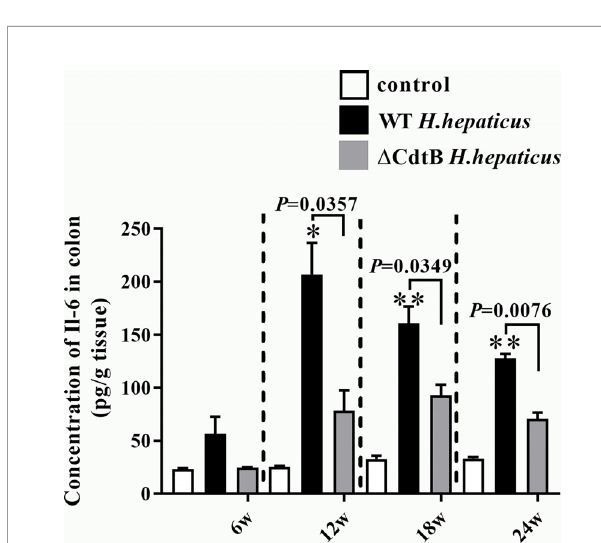
FIGURE 4 | H. hepaticus infection induced the expression of pro-in fl ammatory cytokines. Colonic gene expression of pro-in fl ammatory cytokines (A) Il-6 , (B) Tnf- a , (C) Il-1 b , and (D) iNOS was analyzed by real-time qPCR and normalized with the housekeeping gene GAPDH. Data are expressed as the means ± SEM (n = 5/ group). * refers to the P value when compared with the control group, * P < 0.05, ** P < 0.01, and *** P < 0.001.